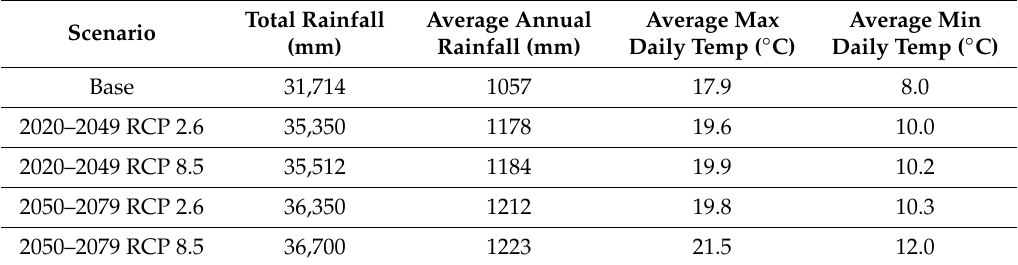
Table 3. A comparison of rainfall depth and daily temperature for the baseline and four climate change scenarios using the Change Factor Method (CFM)